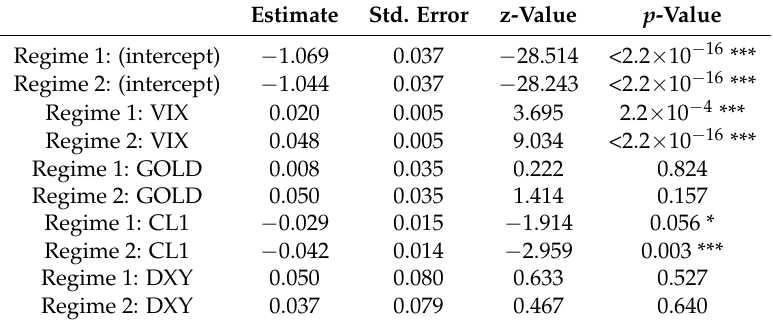
Table 7. Estimated parameters for the multinomial logit models to explain regimes for the Dow Jones Industrial Average index. Regimes are identified by smoothed probabilities based on the estimated 3-regime Markov switching models. ‘***’, ‘**’, and ‘*’ denote significance at the 1%, 5%, and 10% levels,